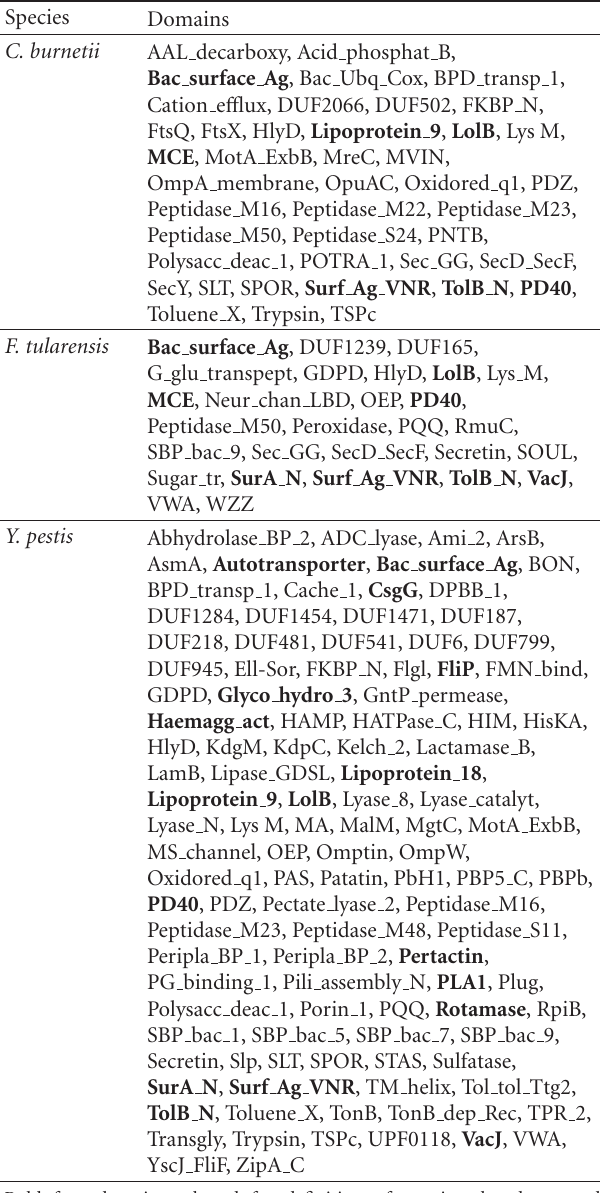
Table 4: Domains associated with secreted CFPs in arthropod- borne